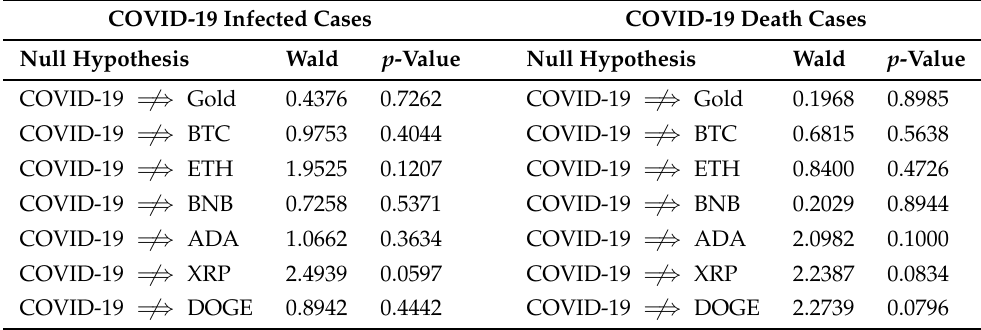
Table 3. Granger causality test results for data of gold prices, cryptocurrency return, and COVID-19. COVID-19 Infected